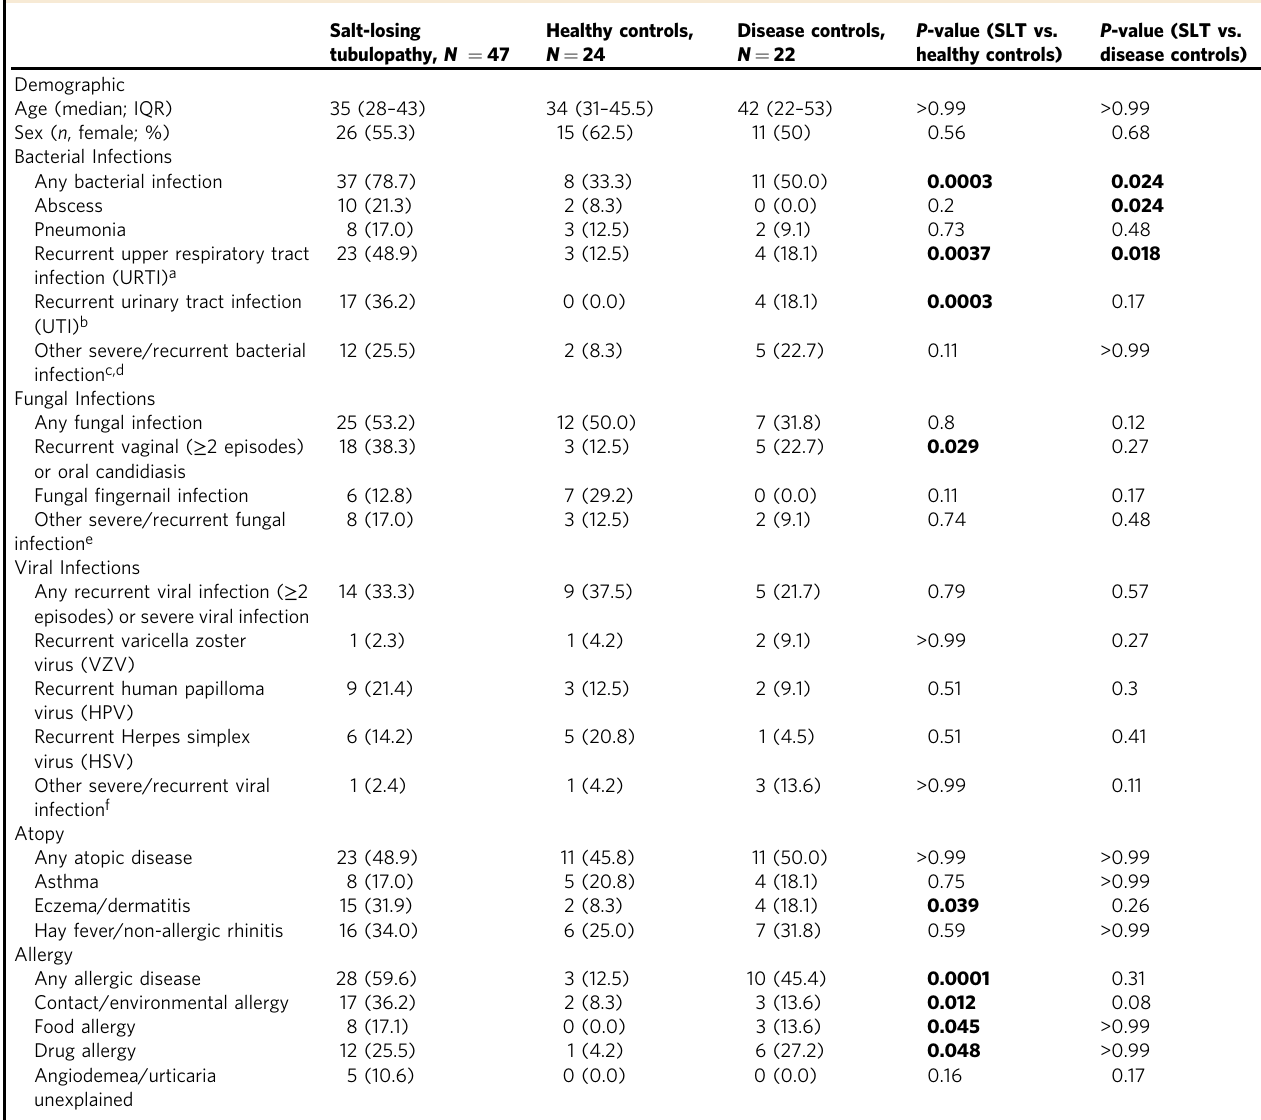
Table 1 Clinical features of dysregulated immunity in patients with salt-losing tubulopathy (SLT) compared to healthy and disease